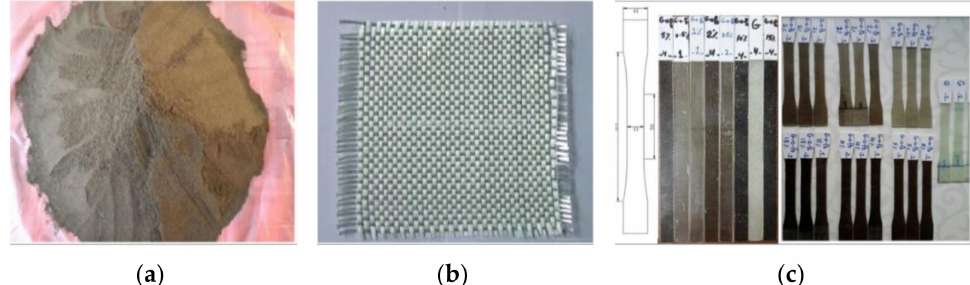
Figure 12. Materials used in production of test samples. ( a ) OP filler, ( b ) S-glass fibers, and ( c ) test samples for dynamic and mechanical tests